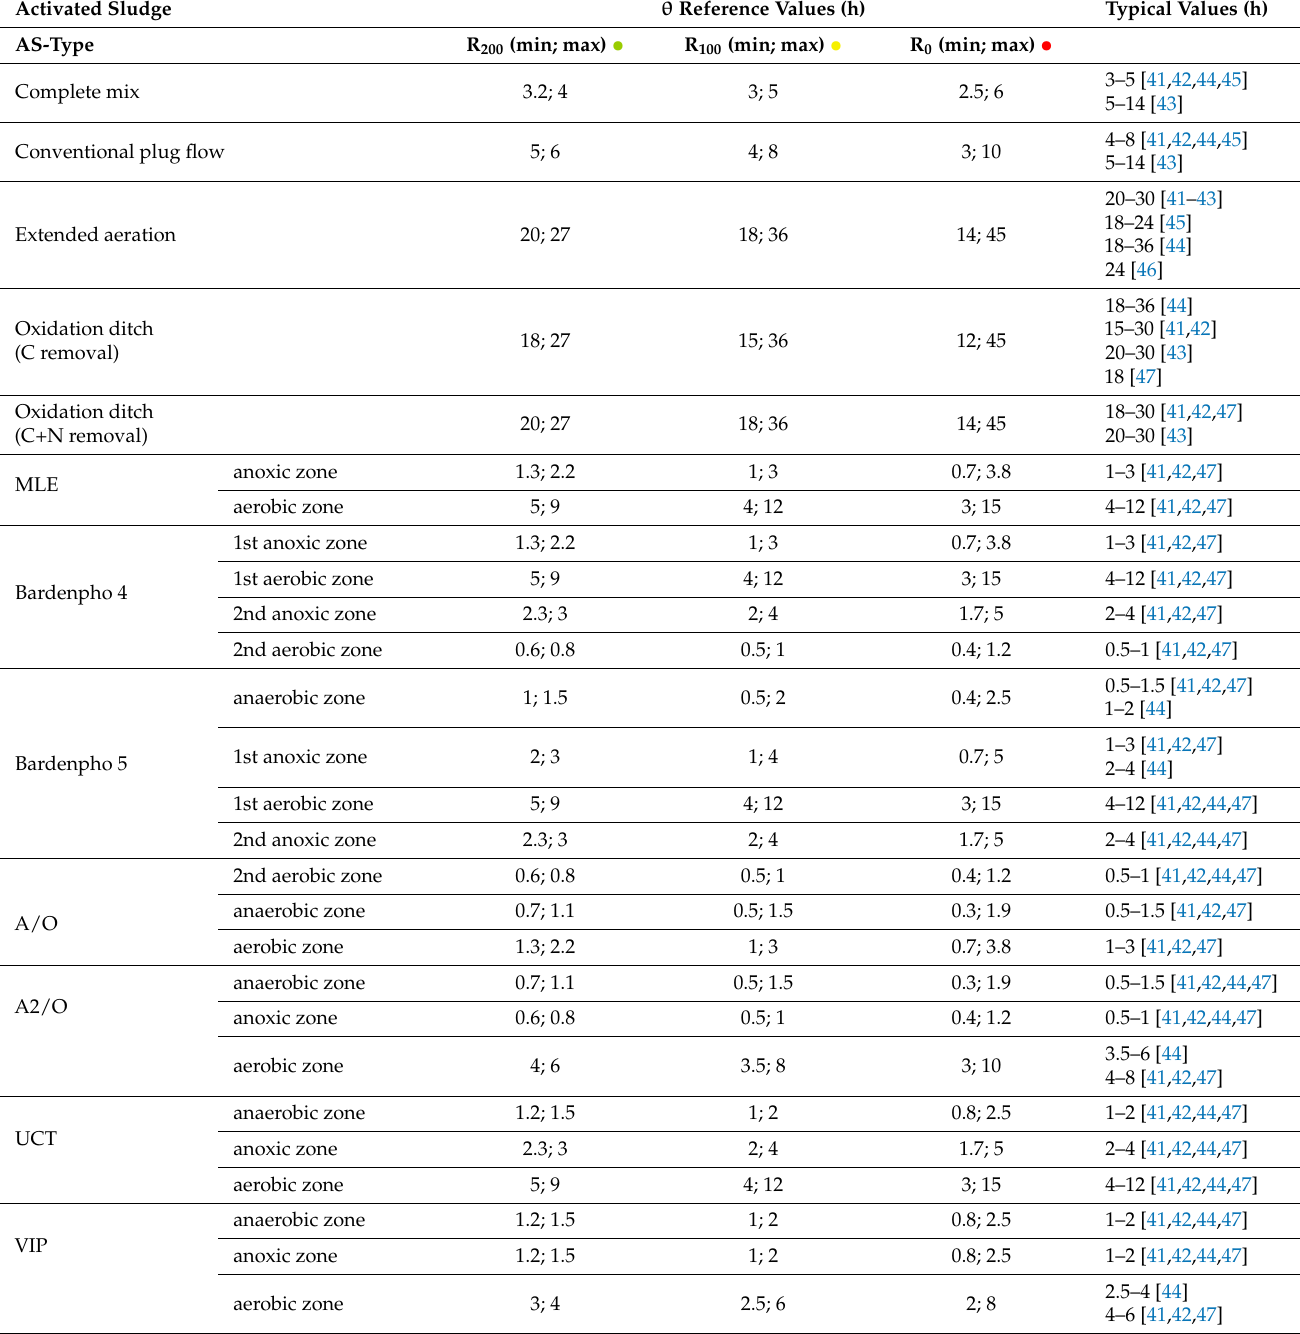
Table 5. The reference values for the hydraulic detention time in AS